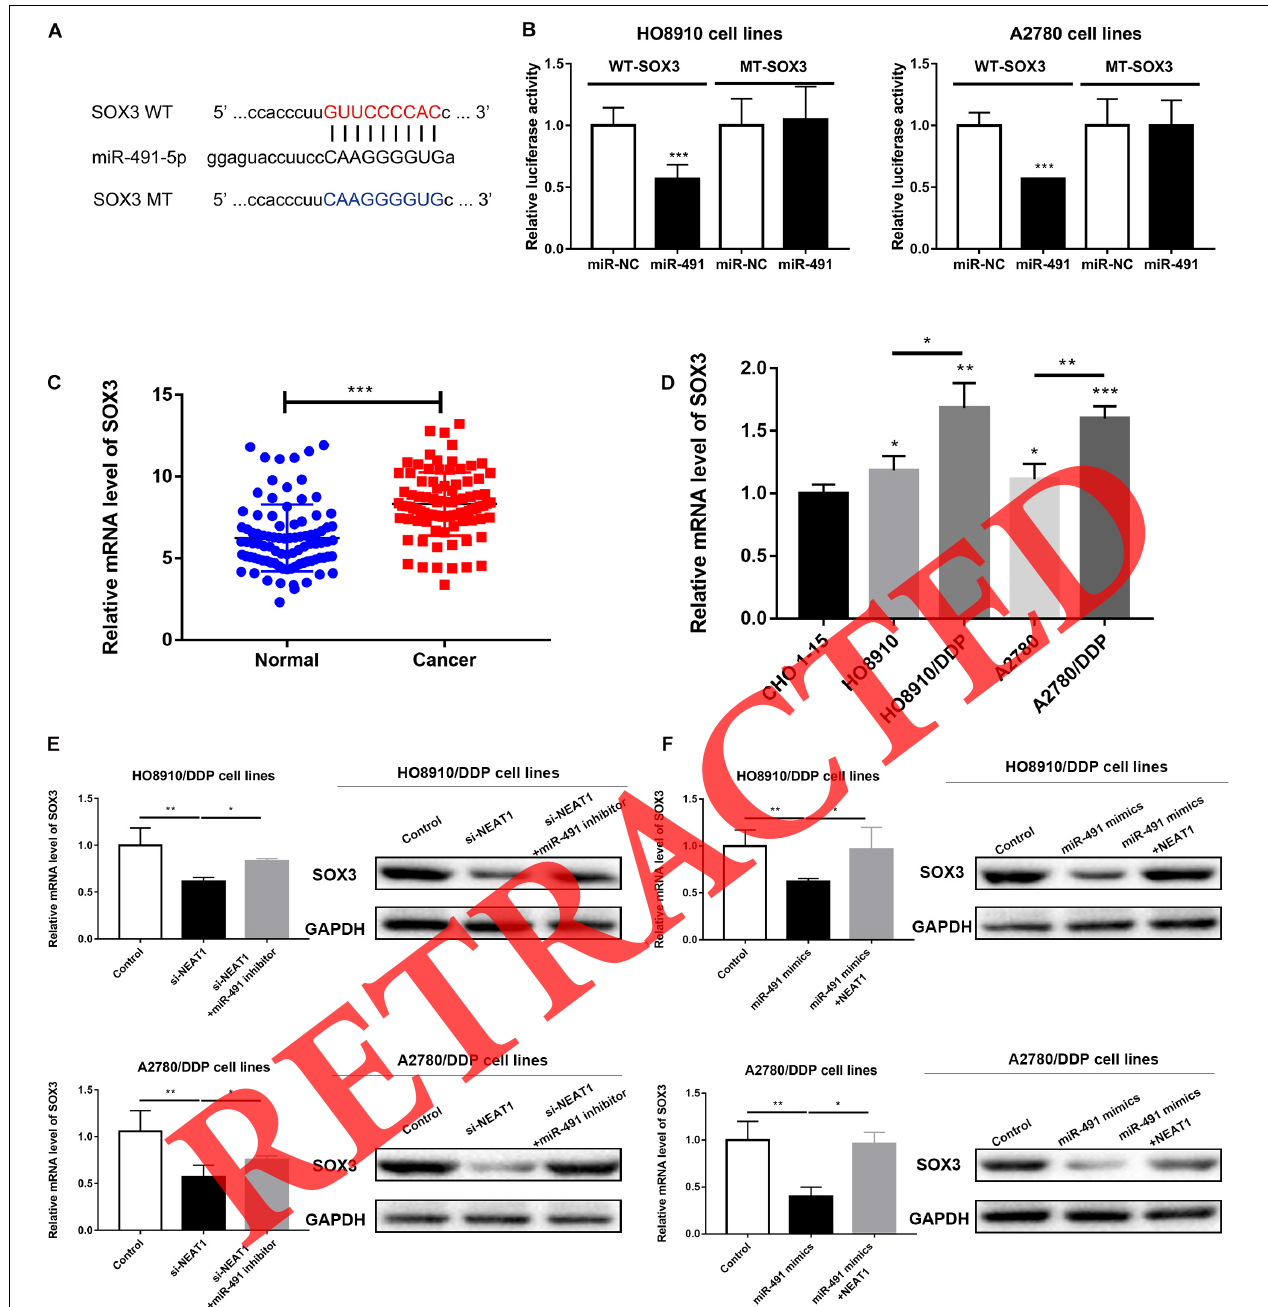
FIGURE 5 | SOX3 was a direct target of miR-491-5p. (A) Binding sites between SOX3 and miR-491-5p predicted by bioinformatics analysis. (B) Luciferase activity of SOX3-WT in OC cells considerably reduced by miR-491-5p mimics as indicated by luciferase reporter assay. (C) Relative SOX3 expression in OC patients. (D) Relative SOX3 expression in cancer cell lines. (E,F) Real-time PCR analysis and Western Blot assay for determining SOX3 expression in cells with rescue assay. All tests were conducted for at least three times. Data were reported as mean ± SD. * p < 0.05, ** p < 0.01, *** p < 0.001.